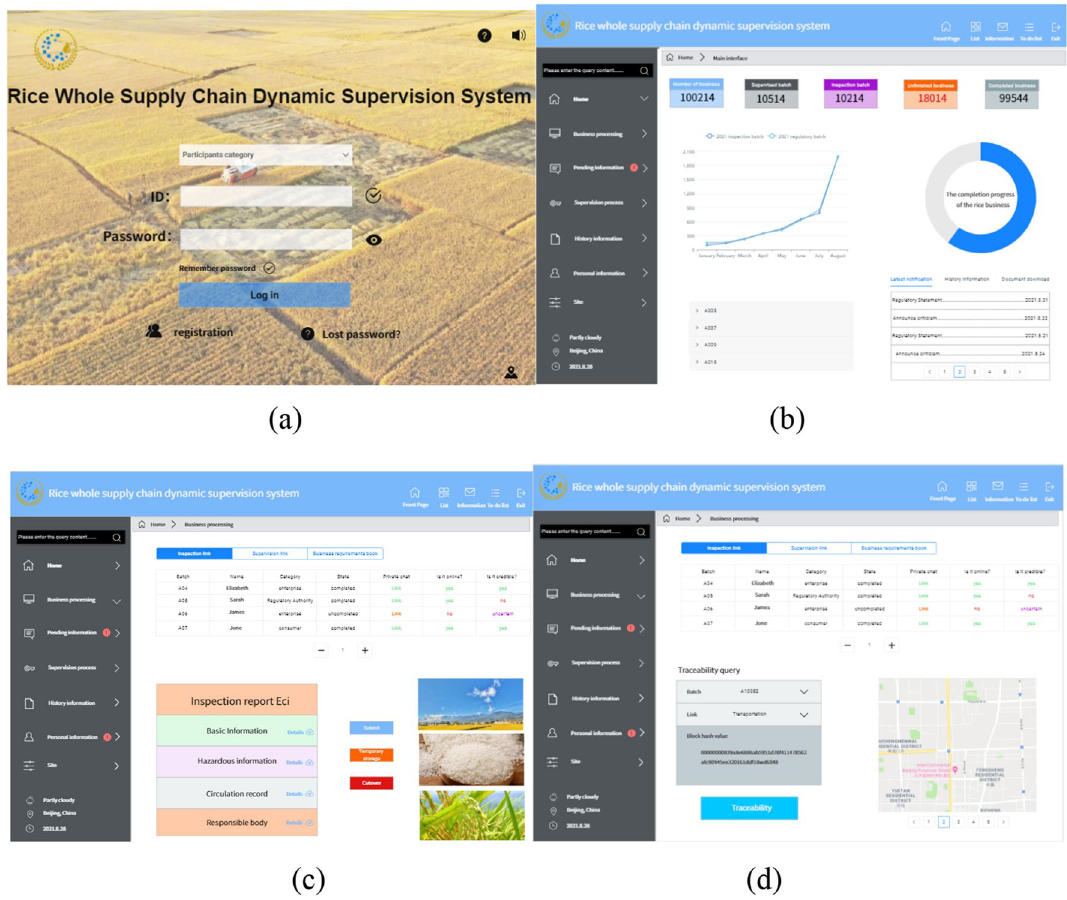
Figure 8. Prototype system interface diagramWe carried out simulation analysis on the prototype system of dynamic supervision of rice supply chain. The hardware environment is: the processor is Intel(R) Xeon Gold 6230 CPU@2.10 GHz 2.10 GHz (2 processors), the memory is 64.0 GB, and the hard disk is 8 T. Software environment: Linux version is 16.0.0, Ubuntu version is 20.04.1. Use Fabric 2.1 to build the prototype system, where the Docker version is 20.10.7, the docker-compose version is 1.25.0, and the Go language version is 1.17.2. Number of nodes: 10 supervisory nodes, 30 enterprise nodes, and 10 consumer nodes.